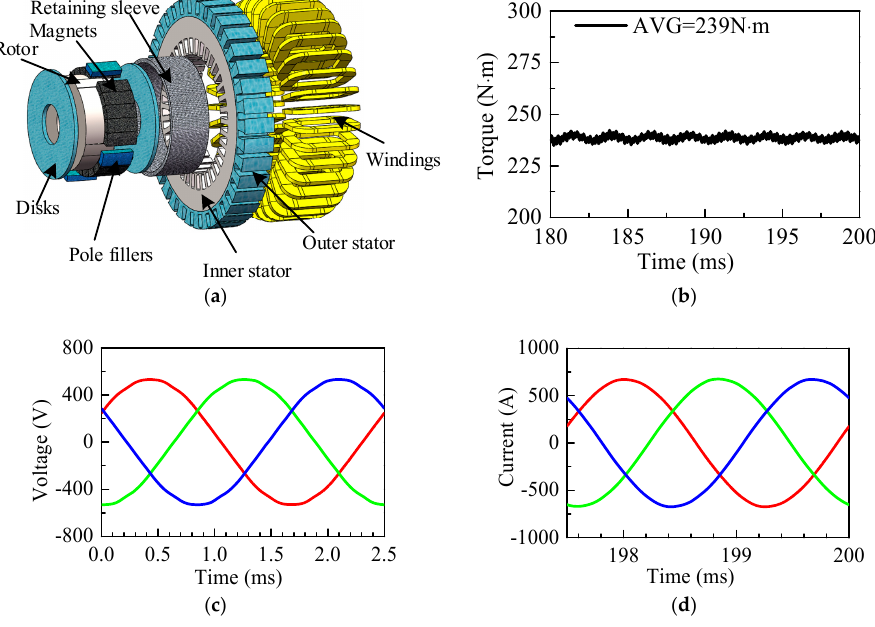
Figure 7. ( a ) Configuration of the prototype; ( b ) waveform of the rated torque; ( c ) waveforms of no-load line back EMF; ( d ) waveforms of rated current. Table 3. Specifications of the prototype.